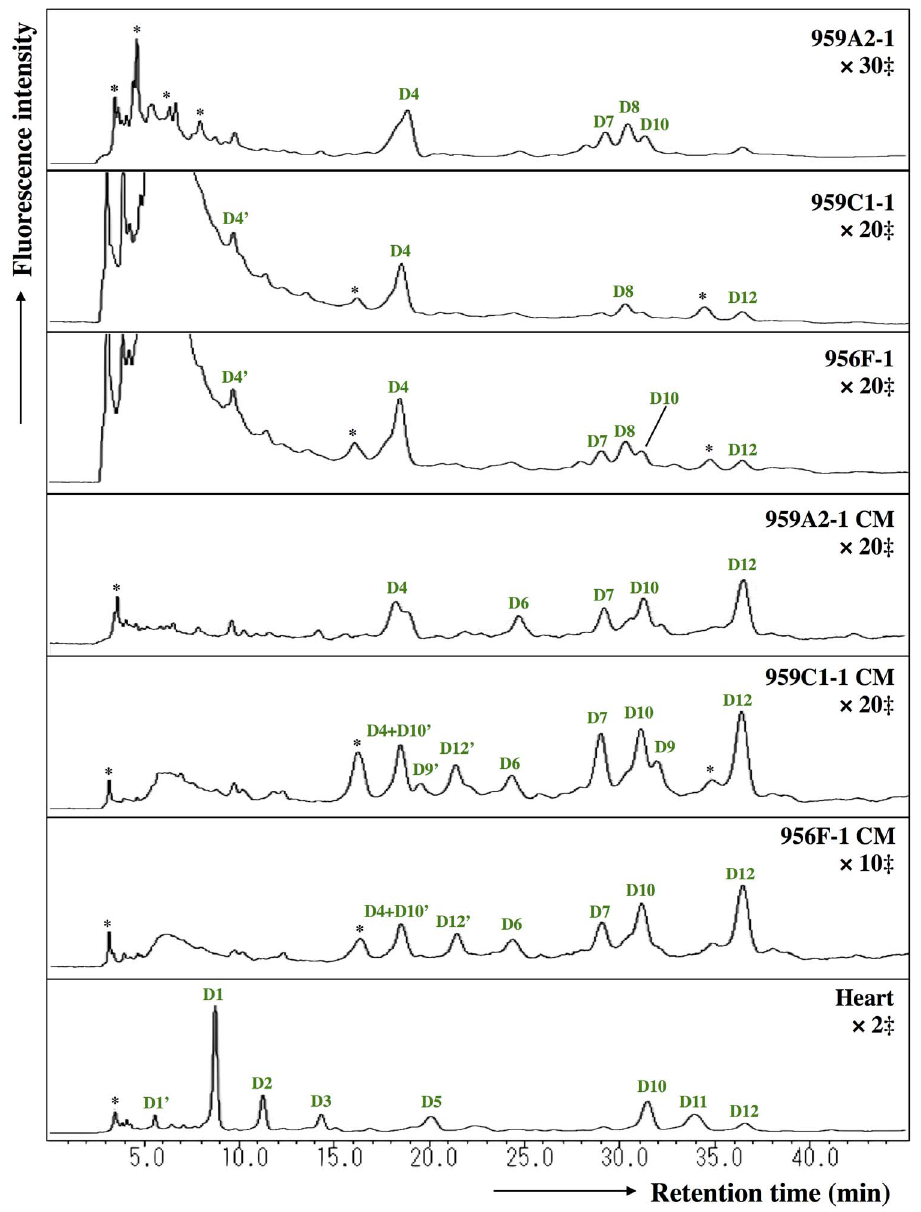
Figure 7. Reverse-phase ODS elution profiles of disialyl PA-glycans. The disialyl fractions were individually applied to the ODS column and eluted according to their hydrophobicity. D1 9 , D4 9 , D10 9 and D12 9 : epimerization of D1, D4, D10 and D12; *Fractions containing no detectable PA- oligosaccharides. ` Magnification ratio to the fluorescence intensity of asialoglycan of each sample.